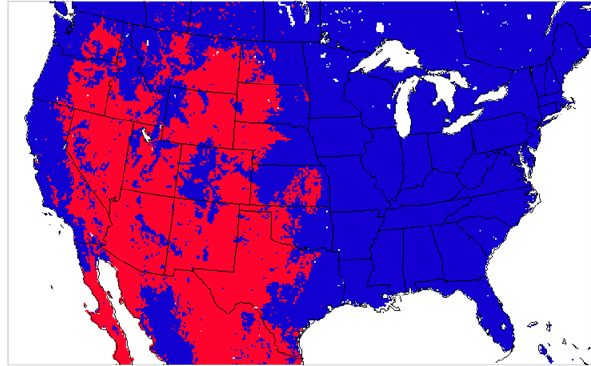
Figure B1. Arid (red) and non-arid (blue) region over continental USA (12km resolution).